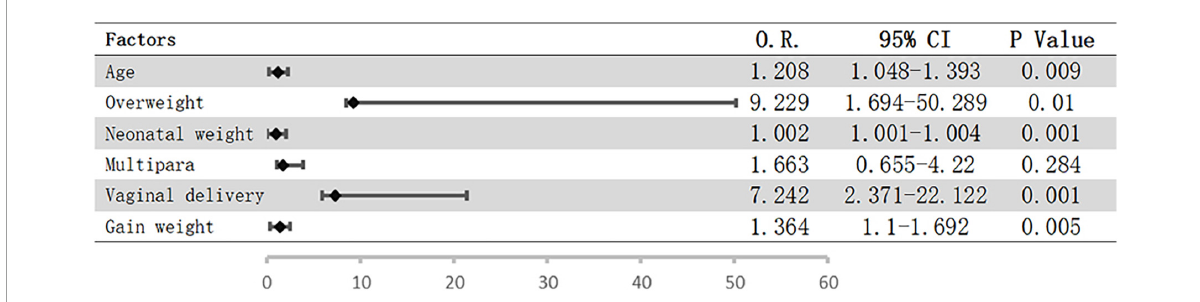
FIGURE1 Possible risk factors for UI using logistic regression. Bars represent 95% confidence intervals; O.R., odds ratio; CI, confidence interval; UI, urinary incontinence.